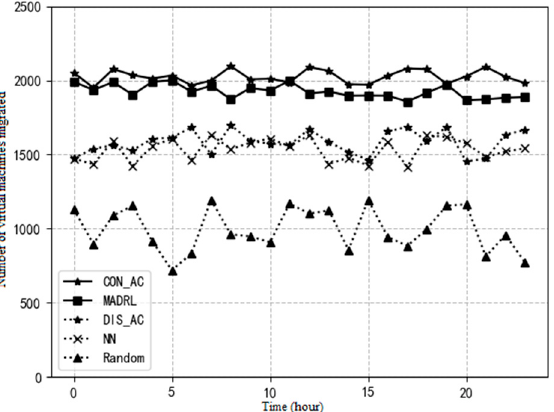
Figure 5. Number of VMs per hour with different migration strategies.